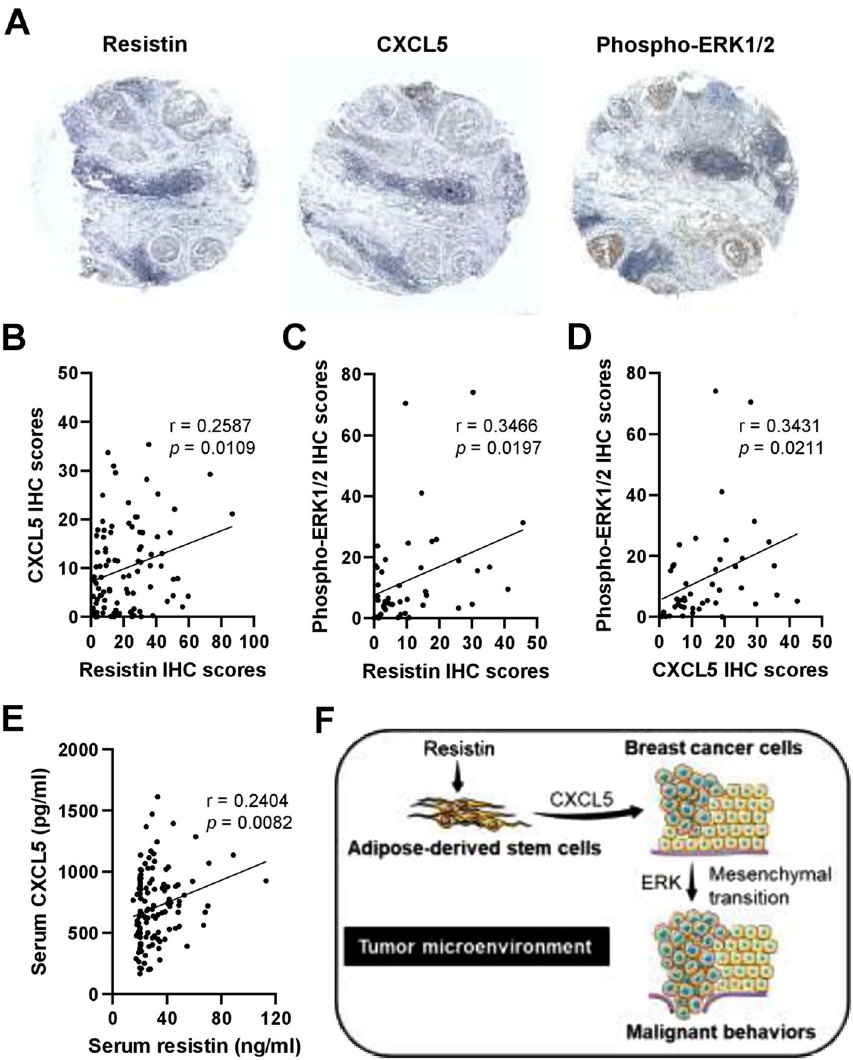
Figure 6. Correlation analysis for the protein expression of resistin, CXCL5, and ERK phosphorylation in the tumor and serum specimens from breast cancer patients. ( A ) Representative images of immunohistochemistry (IHC) staining for resistin, CXCL5, and phospho-ERK1/2 expression in breast tumor sections from breast cancer patients. ( B–D ) The quantitative IHC scores were evaluated by HistoQuest software, followed by Pearson correlation (r) analysis between resistin and CXCL5 in ( B ) (n = 96), resistin and phospho-ERK1/2 in ( C ) (n = 45), and CXCL5 and phospho-ERK1/2 in ( D ) (n = 45). ( E ) The serum levels of resistin and CXCL5 in breast cancer patients were determined by ELISA, followed by Pearson correlation (r) analysis (n = 120). The mean ± SD of resistin and CXCL5 was 31.4 ± 15.4 ng/ml and 707.9 ± 293.4 pg/ml, respectively. ( F )